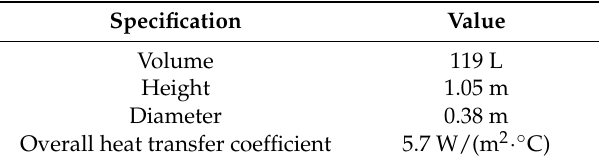
Table 1. Specification of storage tank model for experimental